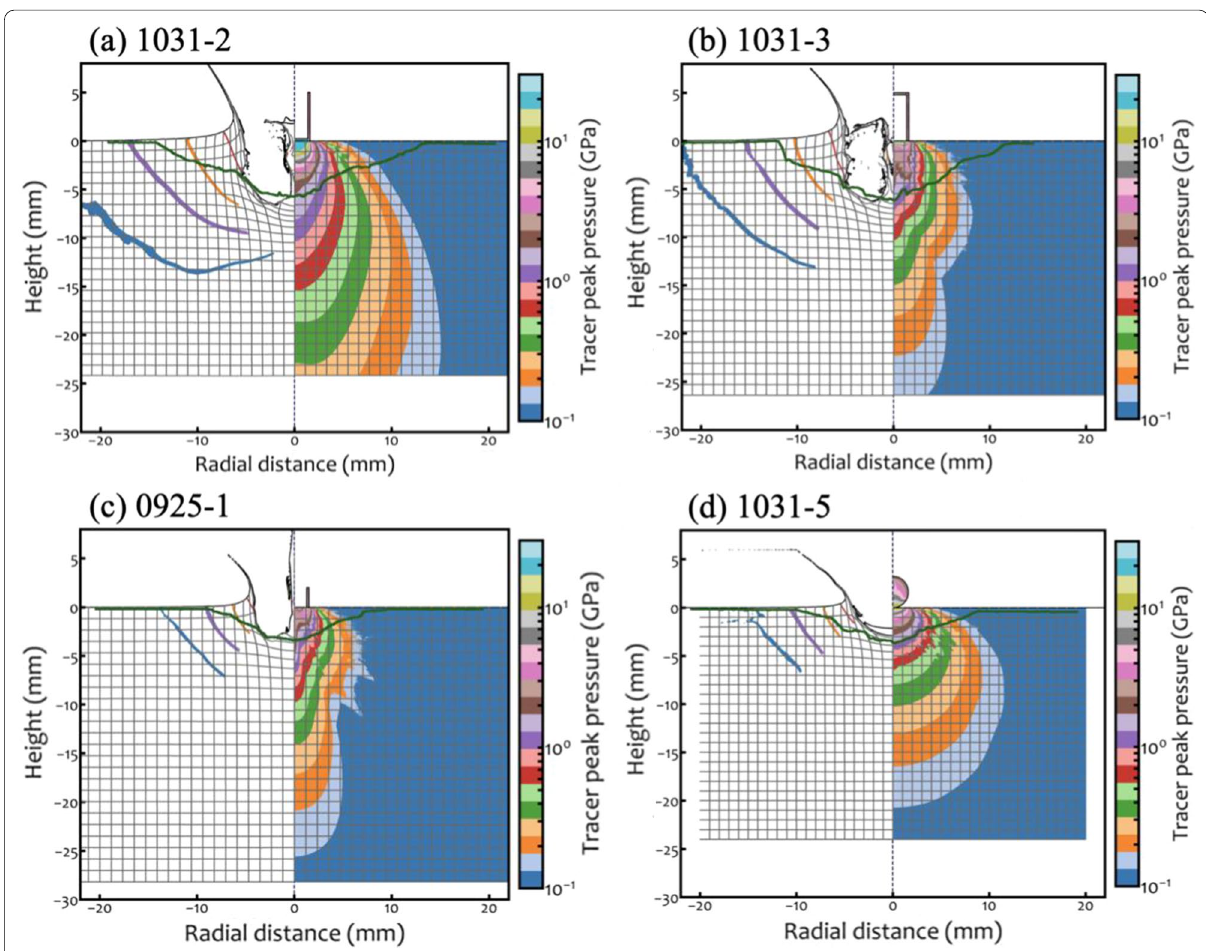
Fig. 7 Results of the numerical simulations corresponding the experiments of a a closed copper tube impacting at the closed side (1031-2), b a closed copper tube impacting at the open side (1031-3), c an open copper tube (0925-1), and d a solid aluminum sphere (1031-5). The right half shows the contour of the maximum (peak) pressures experienced. The left half shows the contour of the upward particle velocity; the blue, purple, orange, and red lines indicate 3, 10, 30, and 100 m/s, respectively. The crater profile in the experiment with the corresponding impact condition is shown for comparison (green